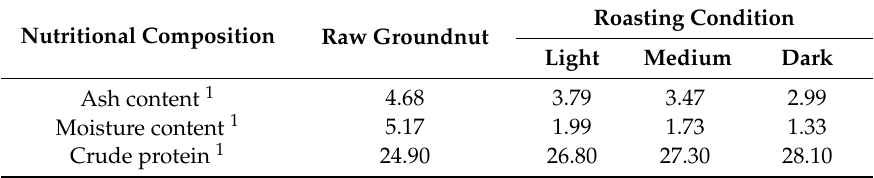
Table 6. Ash analysis, proximate and mineral composition of raw and roasted (light, medium and dark) groundnuts.